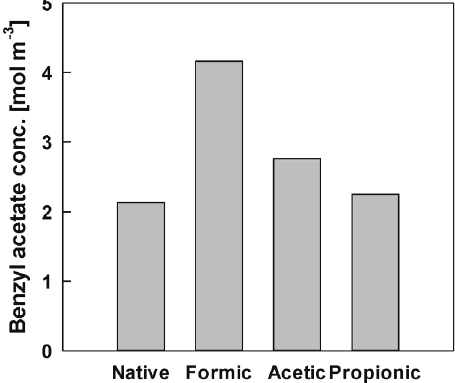
Fig. 1 – Effect of carboxylic acids as bio-imprinting mole- cules on transesterification in [C